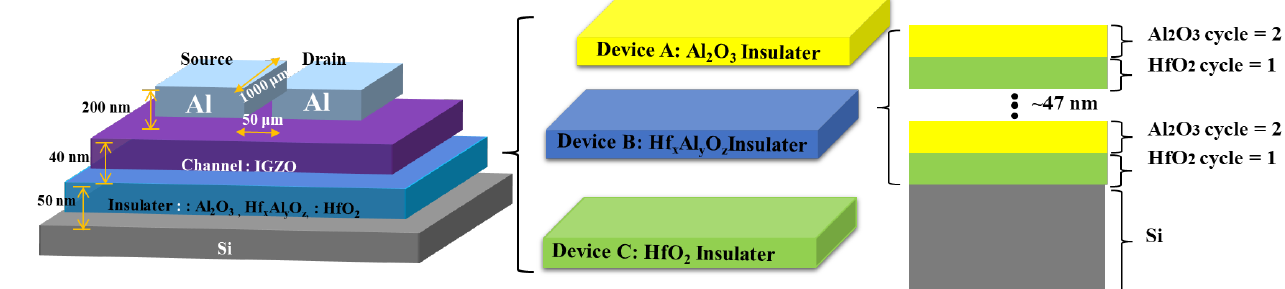
Figure 1. Schematic structure of the devices and Hf x Al y O z nanolaminate film.